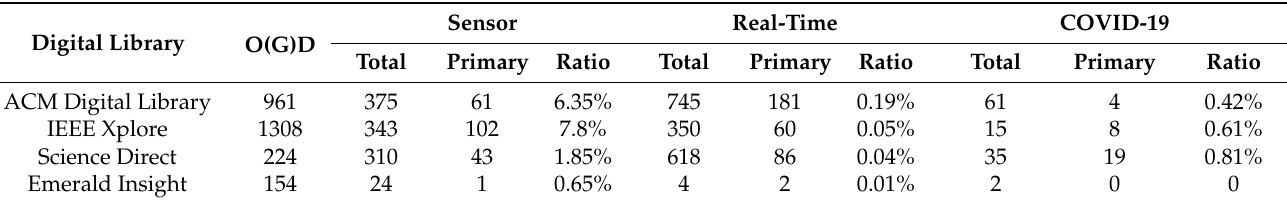
Table 3. Popularity of the topic in the digital